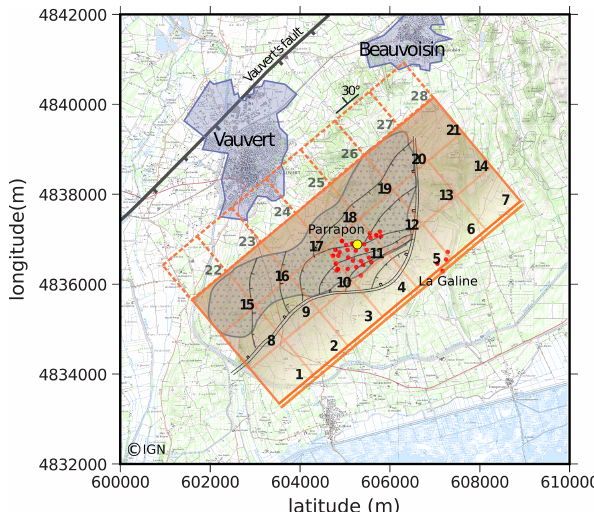
Figure 9. Representations of the dislocation planes (numbering from 1 to 28) are displayed in shaded orange modeling the salt layer (darker shading for deeper planes), along with the currently known boreholes (red dots). The decollements are represented by the double line and listric faults by black lines beneath the site of salt exploitation in Vauvert (France). The allochthonous saliferous unity is represented by the gray dotted area. The limits of Vauvert and Beauvoisin cities are represented by blue areas, and the Vauvert normal fault is displayed using black lines (modified from Valette and Benedicto, 1995). The blue polygons represent the extent of Vauvert and Beauvoisin cities (see Fig. 2b). The background map is extracted from IGN SCAN 1 : 25000 (©